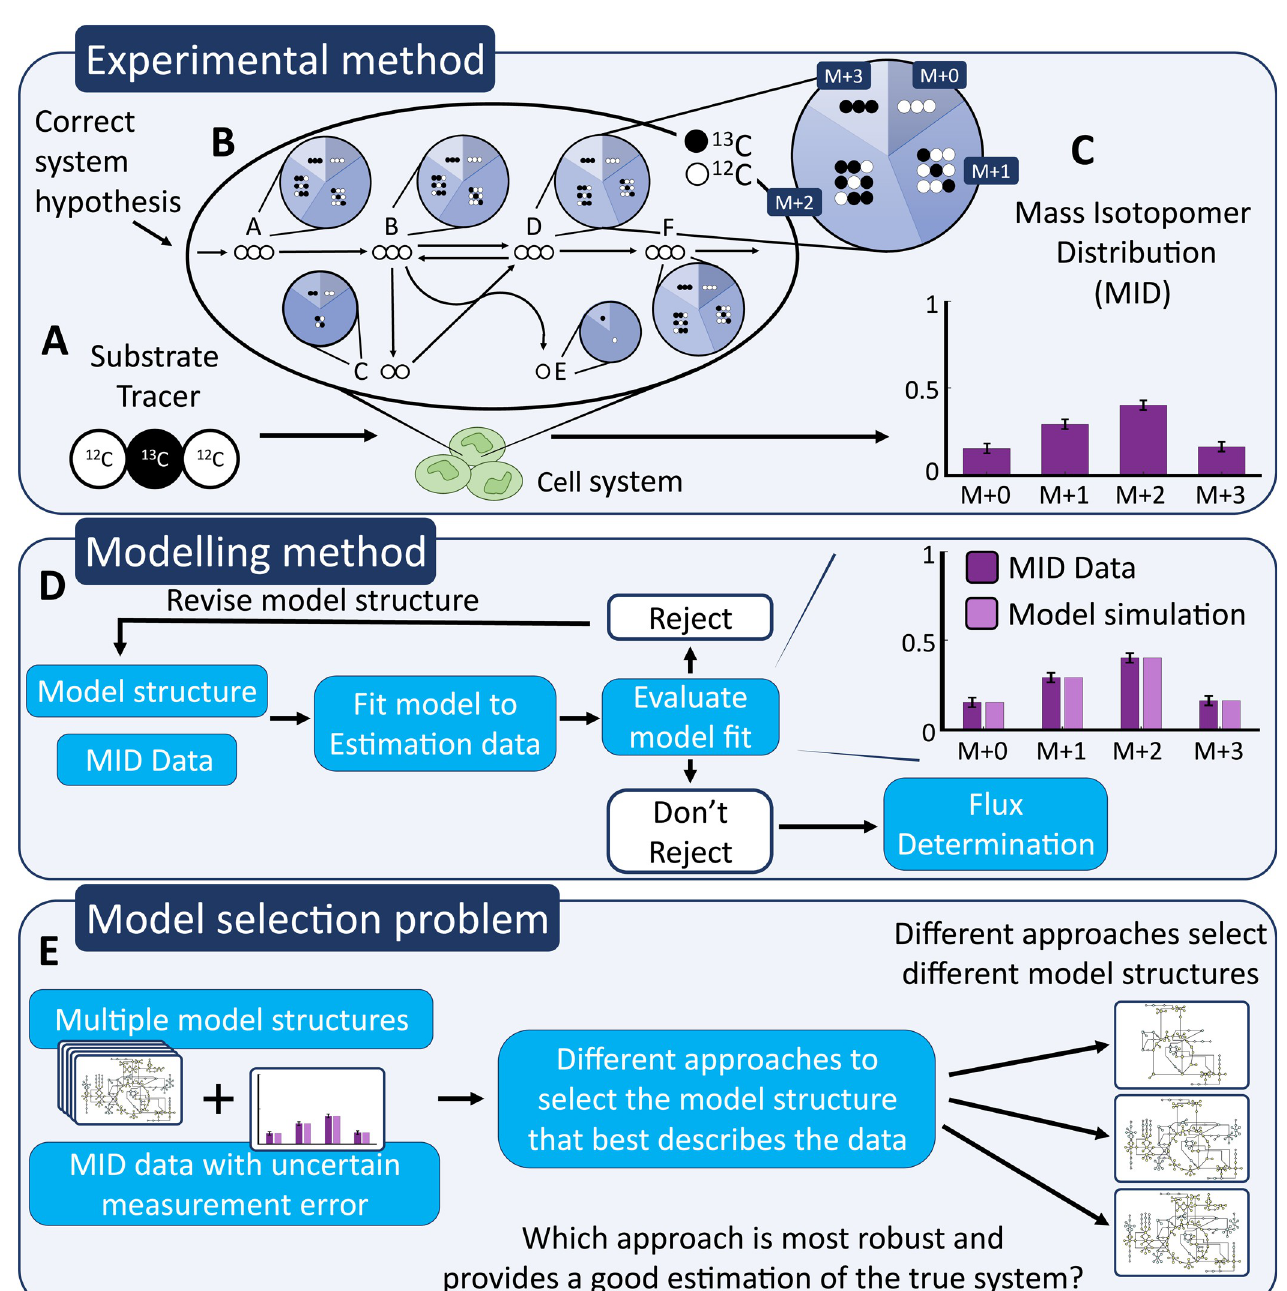
Fig 1. The basic steps in 13 C MFA and the model selection problem. (A) New substrates, containing 13 C (dark circles) are fed to the cells. (B) These substrates are consumed and converted to end products in the cells, according to its biochemical reactions. (C) The labelled 13 C molecules appear to various proportions in each of the mass isotopomers, and these proportions are summed up in these distribution bar charts for each detected metabolite. (D) The iterative modelling cycle in which a hypothesized model structure is fitted to MID data. The model fit is evaluated, usually with a χ 2 -test, and either rejected or not. If the model structure is rejected it is revised and evaluated again. If the model structure is not rejected it is used for flux determination. (E) The iterative model development in (D) results in a model selection problem. Different approaches for solving this model selection problem might result in different model structures being selected. This paper evaluates how the uncertainty in measurement data affects uncertainty in model